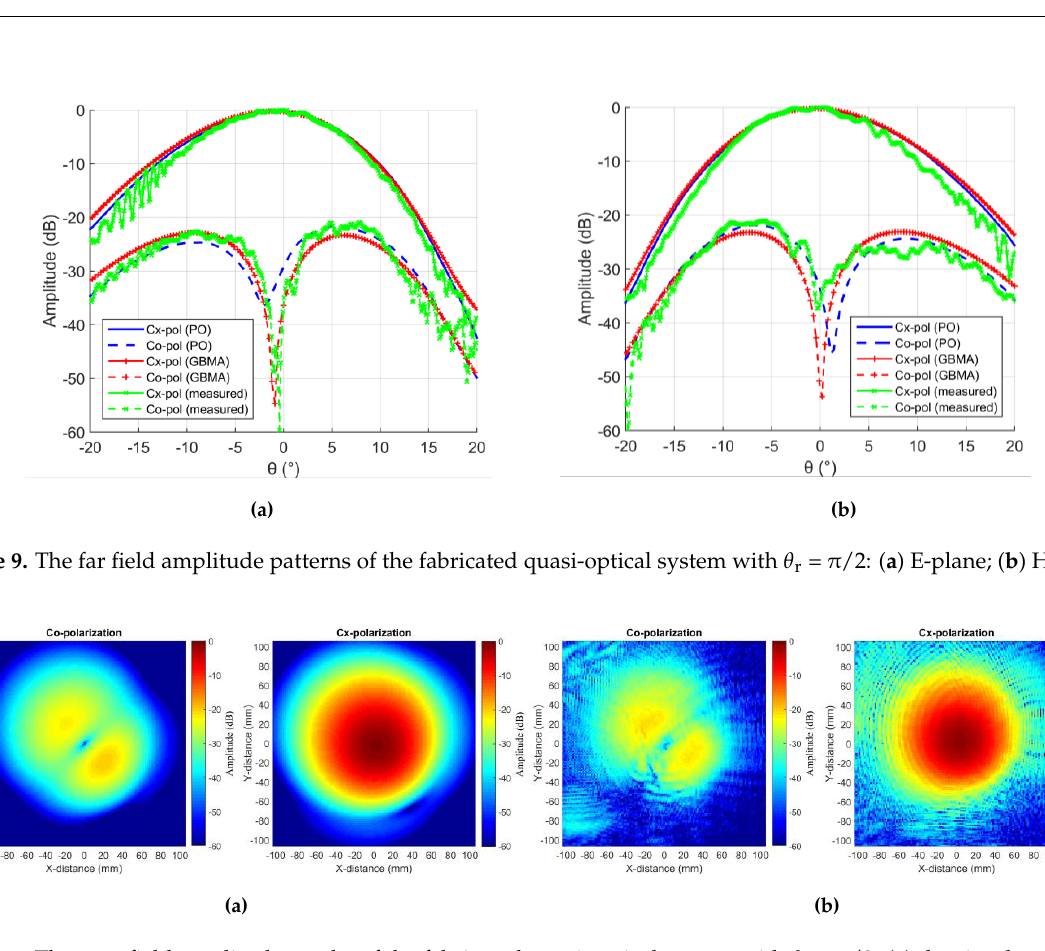
Figure 8. Scanning devices